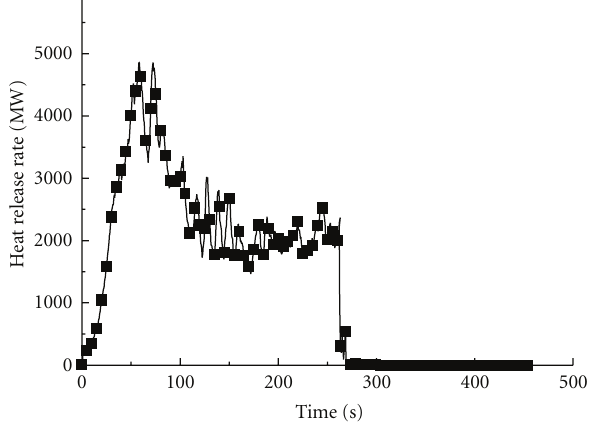
Figure 2: Predicted heat release rate in the train